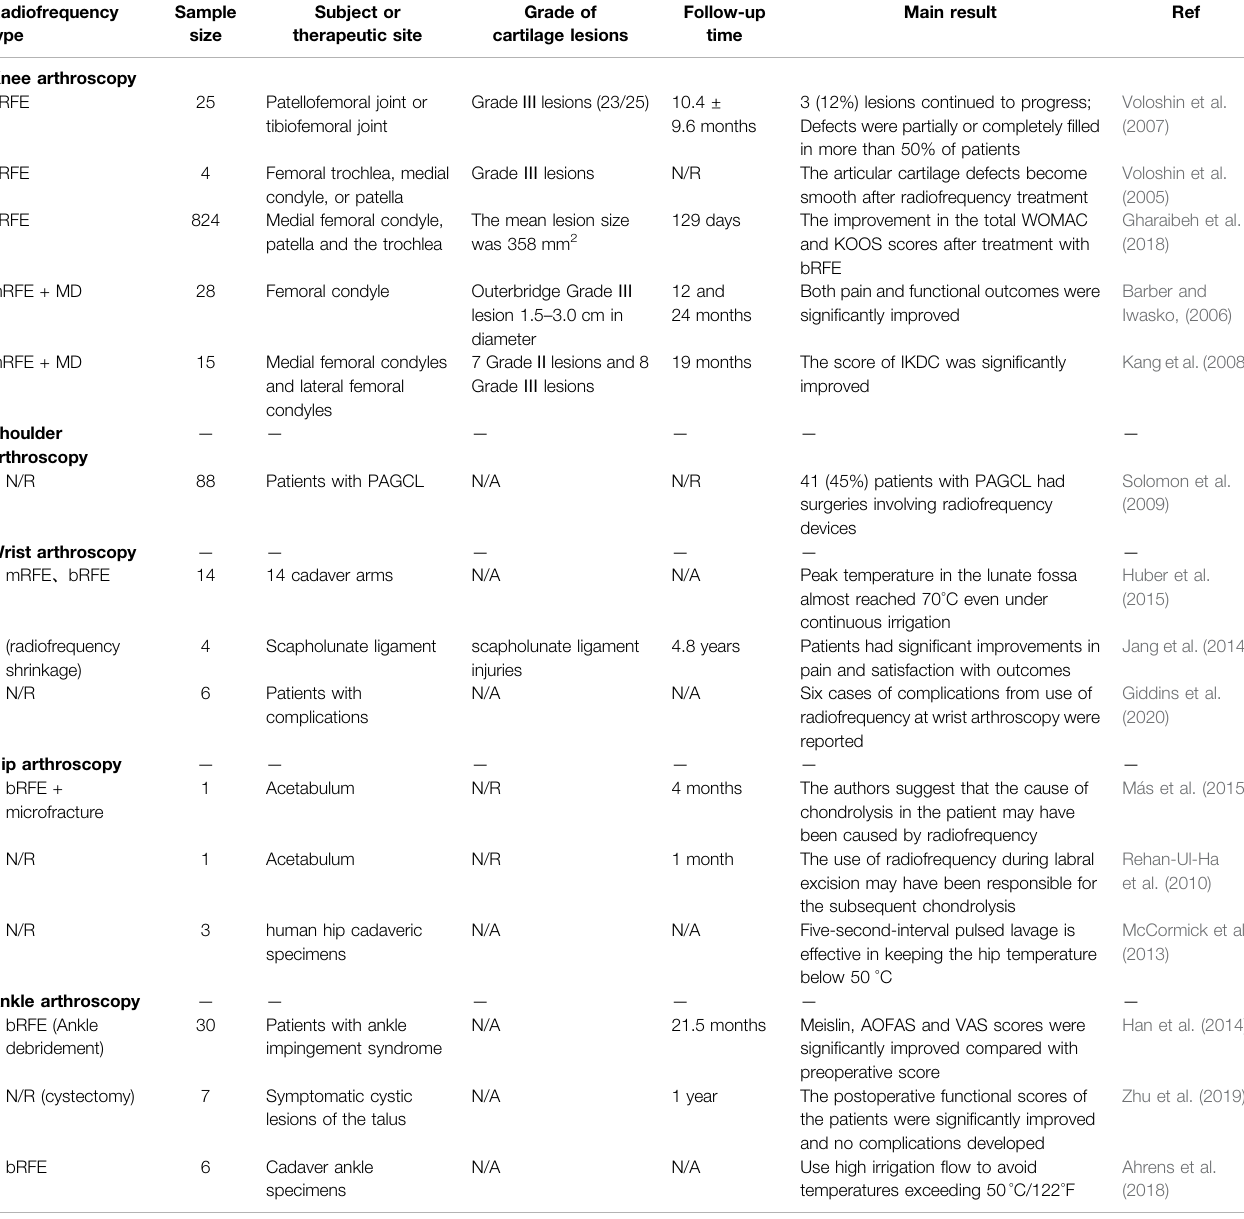
TABLE 2 | Indications: Application of radiofrequency in